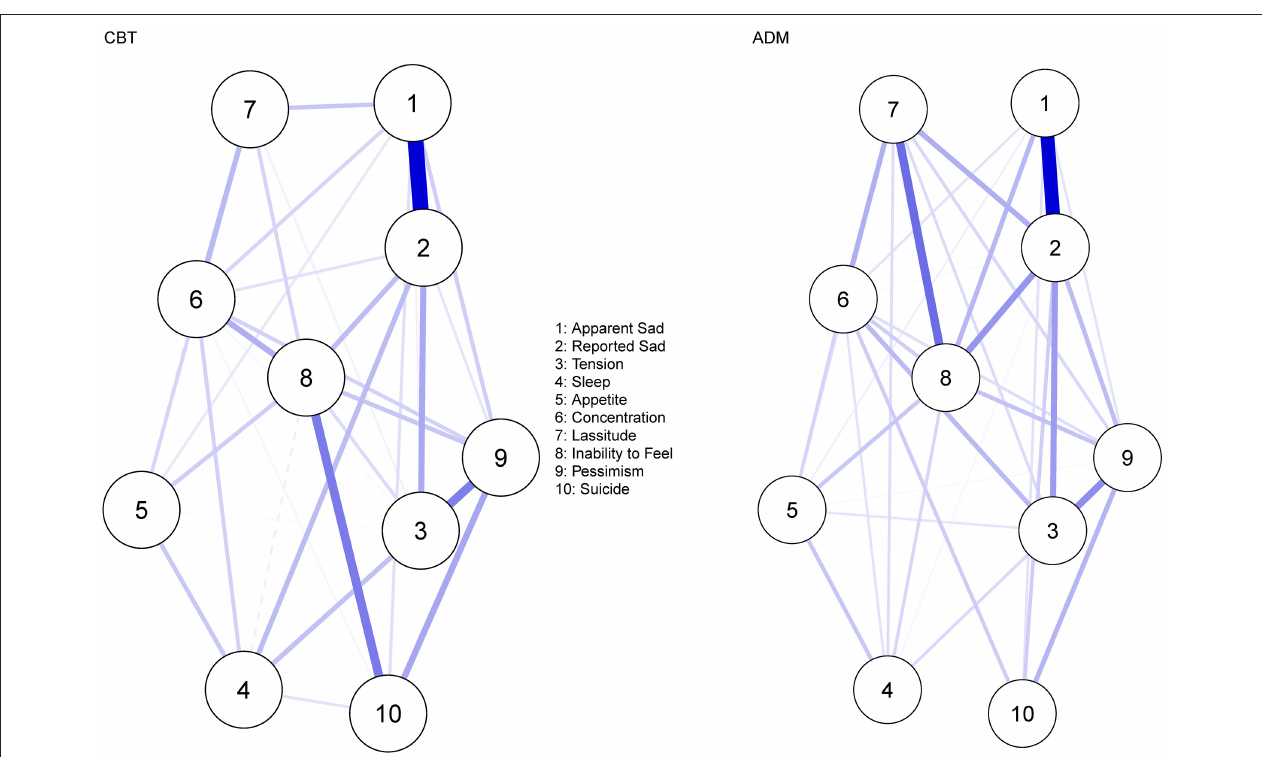
FIGURE 4 | Residual symptom network post-CBT and ADM’s, measured using the MADRS. Blue edges indicate symptom activation and red edges indicate symptom